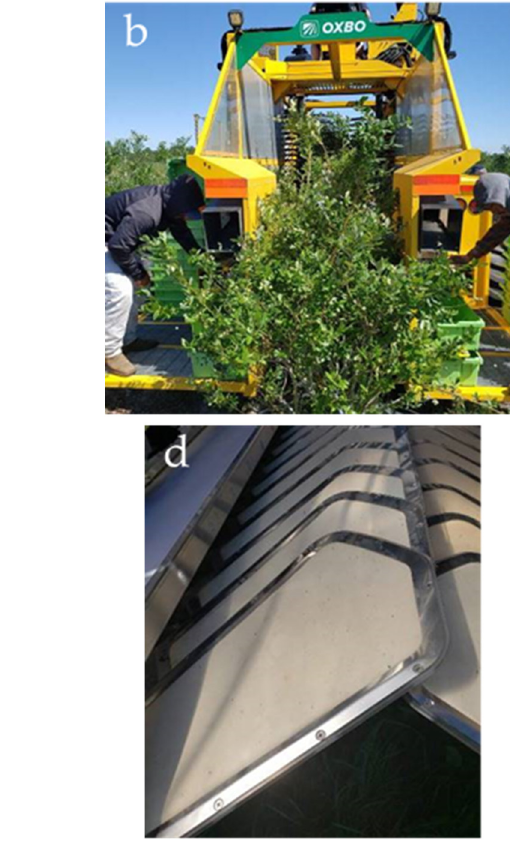
Figure 2. Modified Oxbo 8040 harvester: ( a ) Side view, ( b ) Rear view of fruit collection platforms, ( c ) Front view of soft-catch plates and soft-catch surfaces over rigid conveyors and side panels below vertical drum shakers, ( d ) Closeup view of soft-catch plates and soft inclined surface over the conveyor belt.